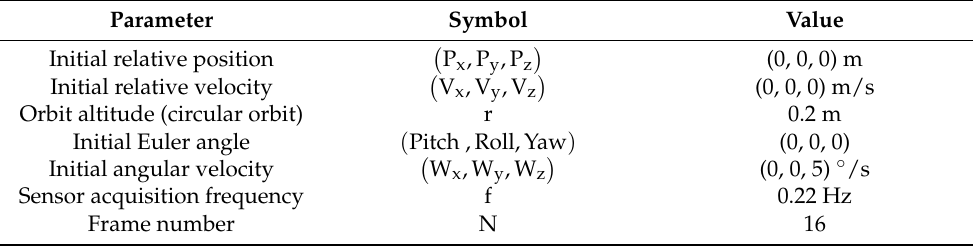
Table 3. Initial parameters set in the numerical simulation